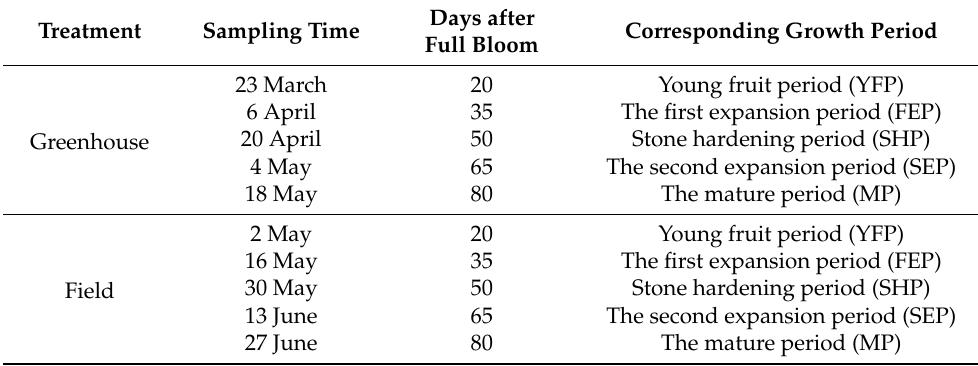
Table 1. Sample collection